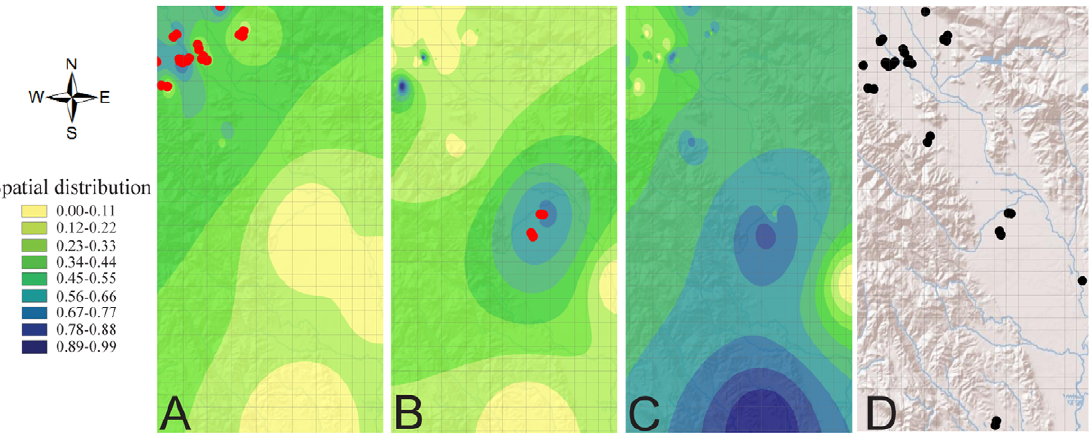
Figure 3. Geospatial and clustering analyses of GLRaV-3 variants in the Napa Valley. Images A through C illustrate results for GLRaV-3a, -3b and -3c, respectively; spatial distribution patterns for each variant are shown using interpolation data. The colored gradient and the corresponding values for spatial distribution represent the proportion for a given GLRaV-3 variant compared to the total number of GLRaV present in the tested block. The red dots indicate localities with statistically supported high incidence (p , 0.01) of a particular variant in relationship to the remaining sample set. Image D shows all blocks positive for at least one GLRaV-3 variant. Each grid box represents 1 km 2 .